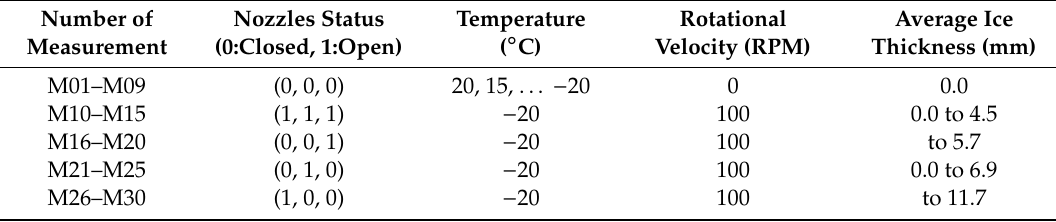
Table 1. Performed measurements at the composite rotor with different parameters.